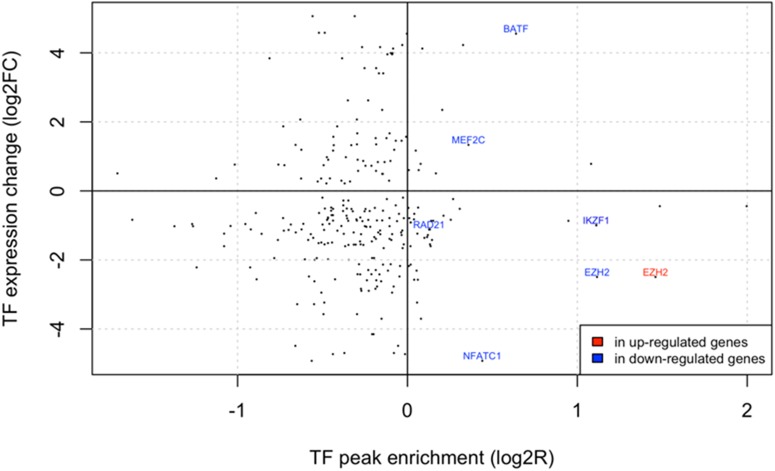
ENCODE TF peak enrichment near TSS of dysregulated genes.The y-axis corresponds to the minimal TF expression change observed among all subtypes. The x-axis corresponds to the peak enrichment ratio for genes that are up- or down-regulated in all subtypes. All TFs are represented as dots and text labels have been added when both expression change and (positive) peak enrichment are statistically significant (FDR < 0.1).